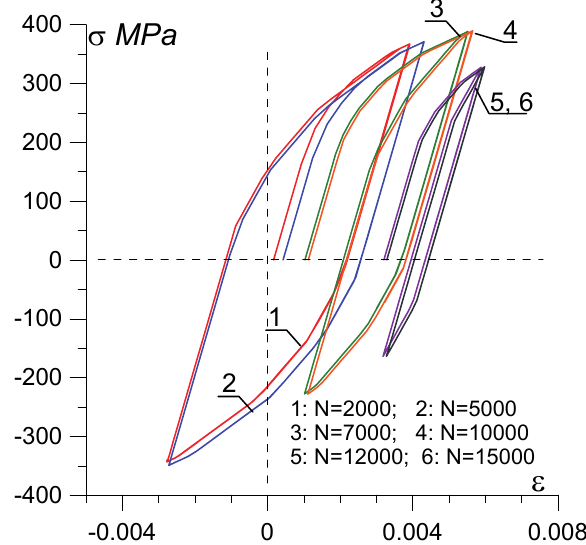
Figure 9: Stress-strain loops at the increasing mean load value calculated with the use of Garud-Mroz model.